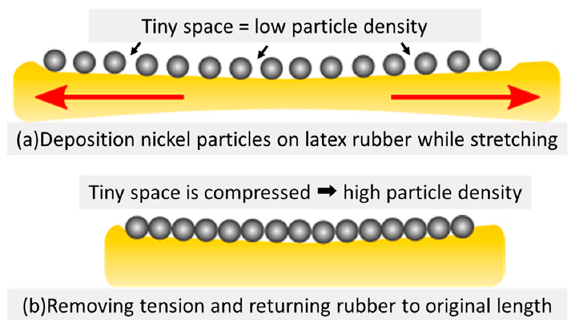
Figure 8. Concept and content of the extending latex rubber. ( a ) When the particles were adhered in an extended state, there was the possibility that a tiny space existed between the adhesion particles, causing low particle density. ( b ) By returning the rubber to its original length, the tiny space was compressed and the particle density increased.